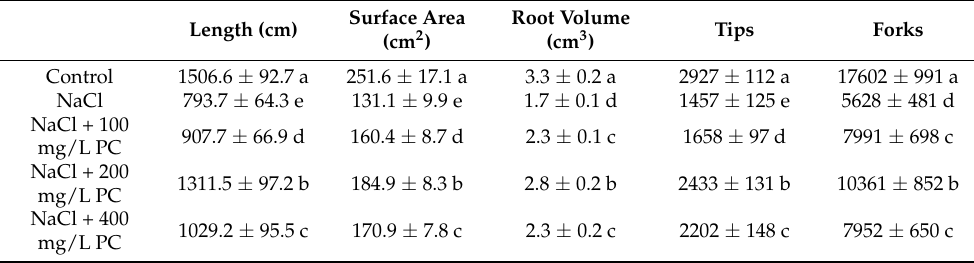
Figure 3. Structural changes in the peach root system under salt stress. ( A ) Photo of the peach tree root structure, the figures of roots in the second column are where the data were collected by the root analysis software. The collected data are root length, surface area, root volume, tips, and forks. ( B ) Fine root distribution heat map. The vast majority of root lengths were distributed in the range of 0 < L ≤ 1, and the root number of NaCl + 200 mg/L PC treatment was the highest in the range of 0 < L ≤ 0.5 under salt stress. Measurements were performed using the intact root system of the peach plant. Measurements of root structural were performed at 10:00 am on 11th day of the salt stress treatment. Bars correspond to 5 cm. Table 2. Peach tree root length, surface area, root volume, tips, and forks.